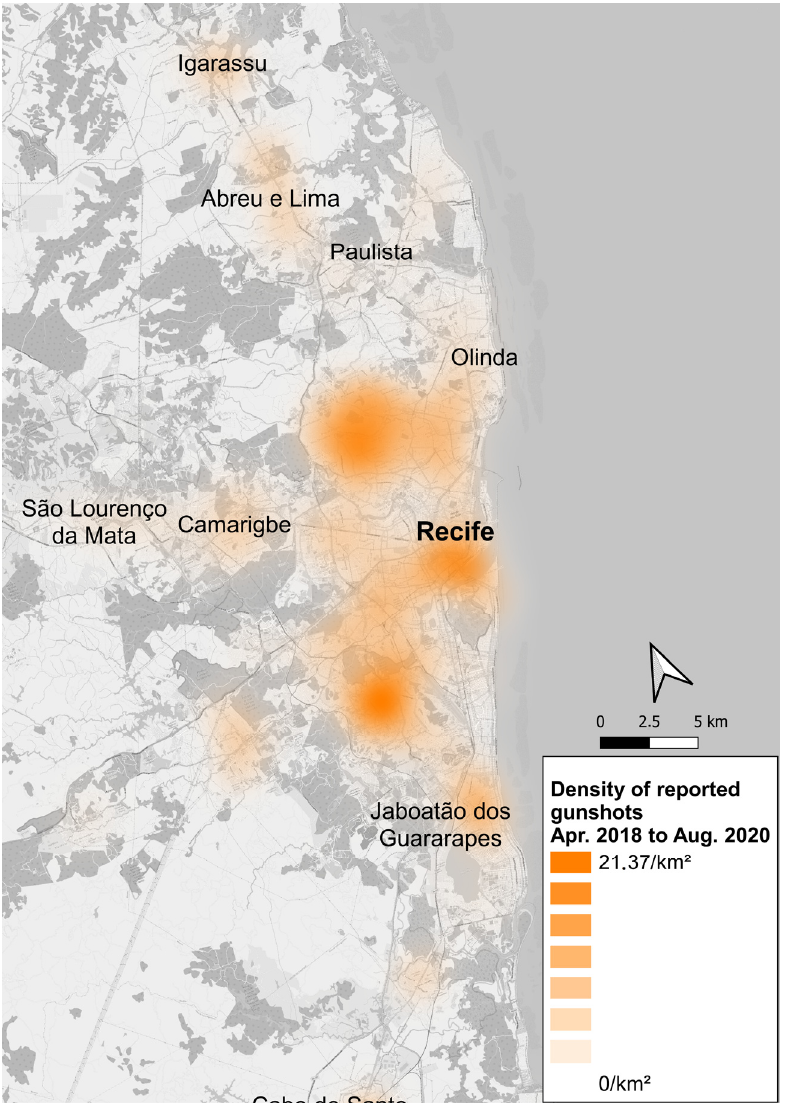
Figure 2. Map of reported gunshots derived from VGI data shown to interview participants. Gunshot data from FogoCruzado (2021); Basemap derived from OpenStreetMap.